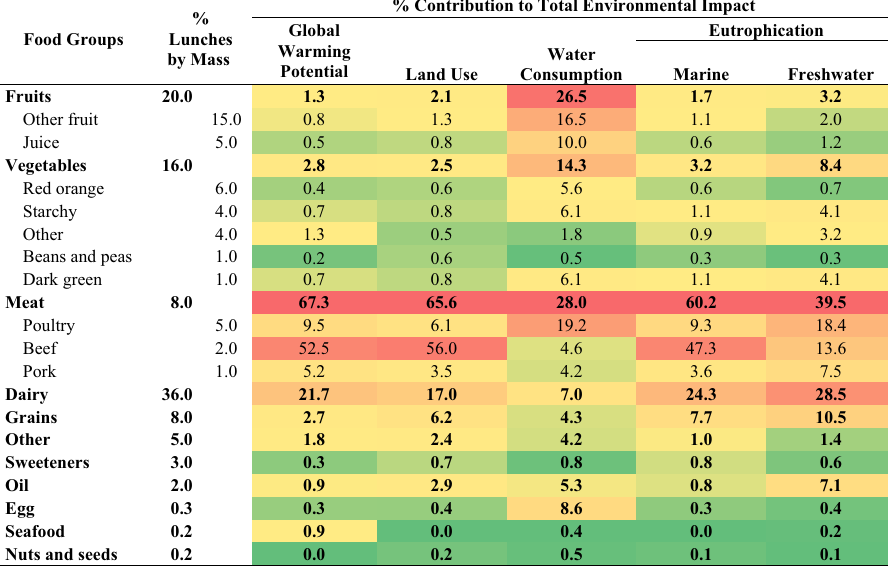
Fig. 2 Total lunch composition and percent contribution of impacts from food groups for lunches served in the National School Lunch